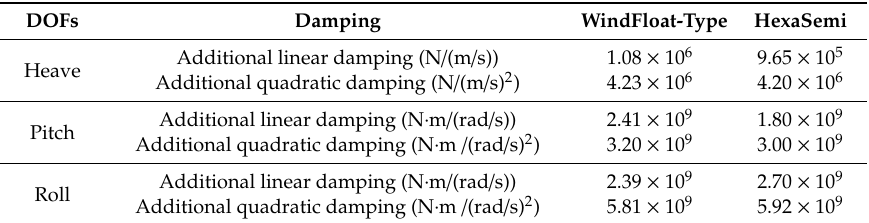
Table 5. Additional linear and quadratic heave damping of the two platforms.